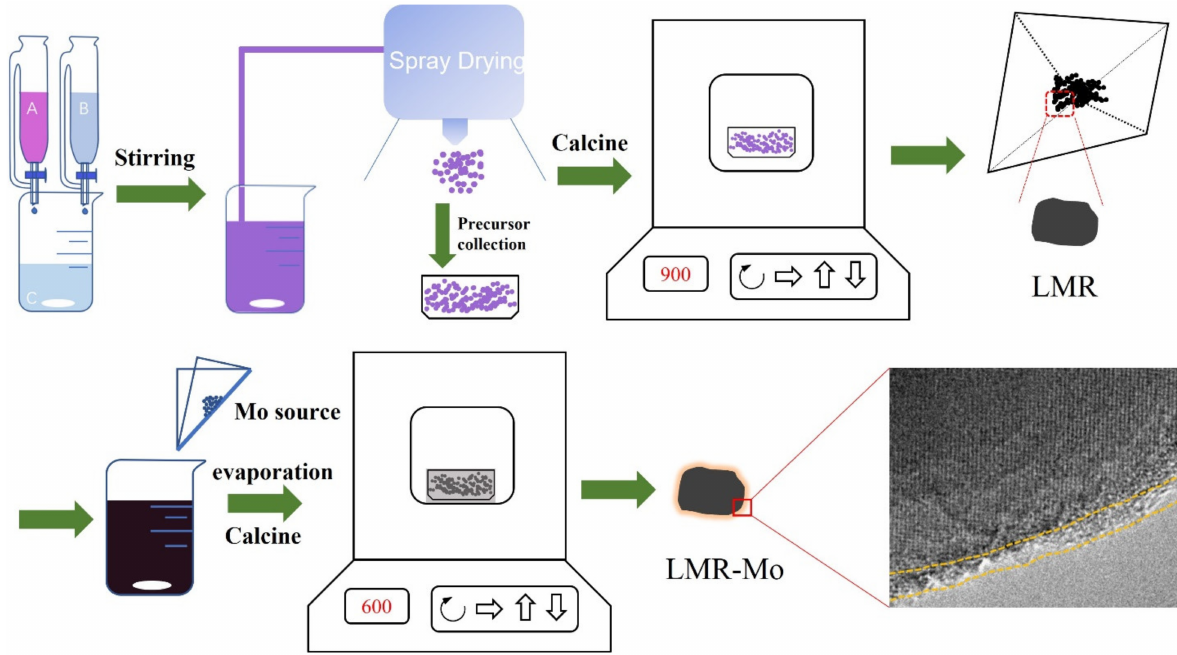
Scheme 1. Illustration of the synthesis process of LMR and LMR-Mo